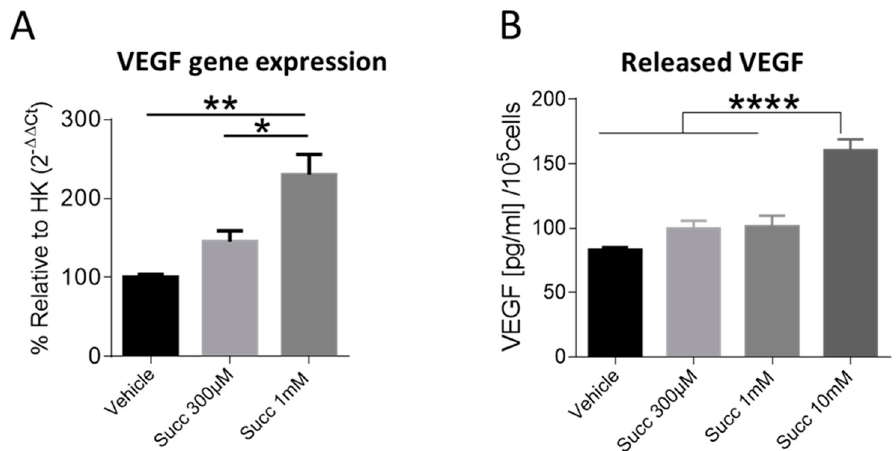
Figure 6 . Succinate induces VEGF gene expression and release in HUVECs . ( A ) RT-PCR of